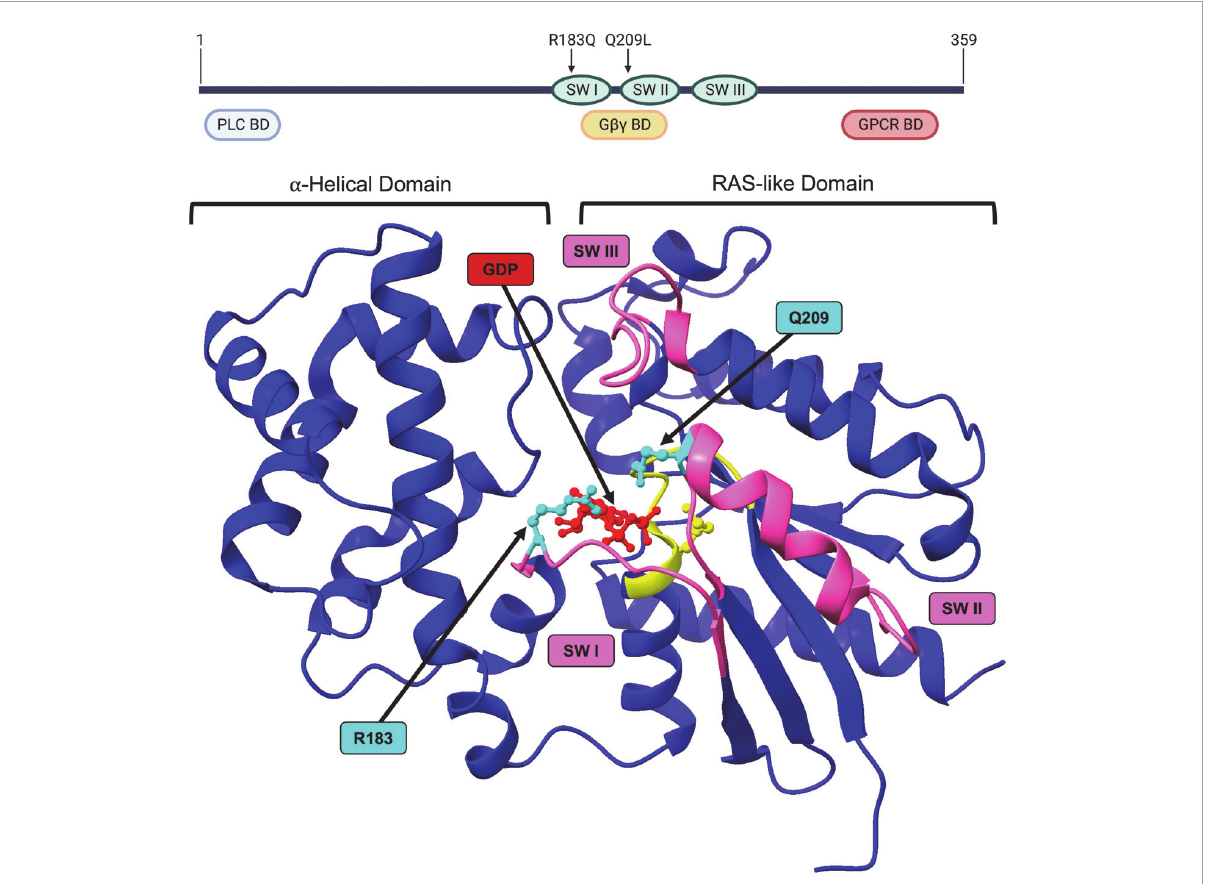
FIGURE3 Structure of GNAQ. Protein map of GNAQ. GNAQ has 3 switch regions (SW): switch regions I and II are part of the GTP binding cleft and have a RAS-like domain for GTP hydrolysis; all three switch regions have key sites for extrinsic regulation by G protein signaling modulators. The p.R183Q and p.Q209L activating mutations are present in switch regions I and II, respectively. GNAQ has a binding domain (BD) for PLC effector function, a binding domain that interacts with the G βγ subunit during the “off” state, and a GPCR binding domain. Image created using BioRender. Crystal structure (PDB ID: 4GNK) with GDP (red) docked in binding cleft and p.R183Q and p.Q209L mutations (cyan). P loop region with Walker A motif shown in yellow. Switch (SW) I, II, and III shown in pink. Supplementary Video available online. Molecular graphics performed with UCSF ChimeraX, developed by the Resource for Biocomputing, Visualization, and Informatics at the University of California, San Francisco, with support from National Institutes of Health R01-GM129325 and the Office of Cyber Infrastructure and Computational Biology, National Institute of Allergy and Infectious